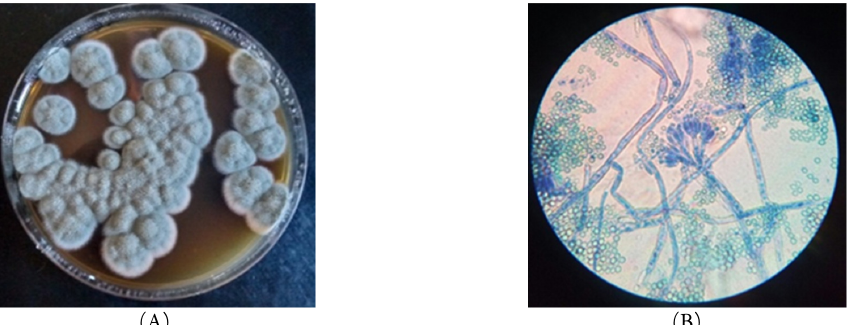
Figure 6. Result of macro and microscopic observation of pathogenic isolateTom10; (A)macroscopic characterization; (B)microscopic characterization